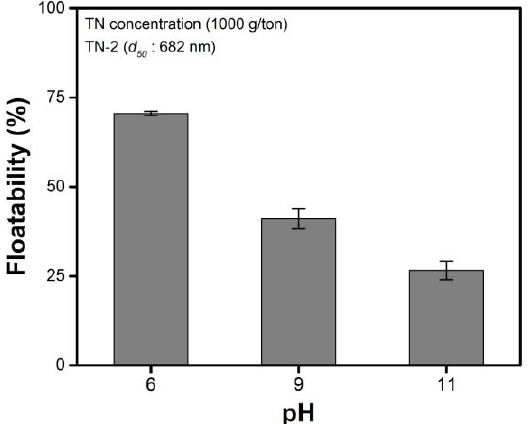
Figure 7. Malachite floatability as a function of the solution pHs. The flotation tests were performed with 1000 g/ton TNs concentration using TN-2. Table 2. The amounts of TNs deposited on the surface of malachite according to changes in pH. The absorbance tests were carried out with 1000 g/ton TN concentration using TN-2.